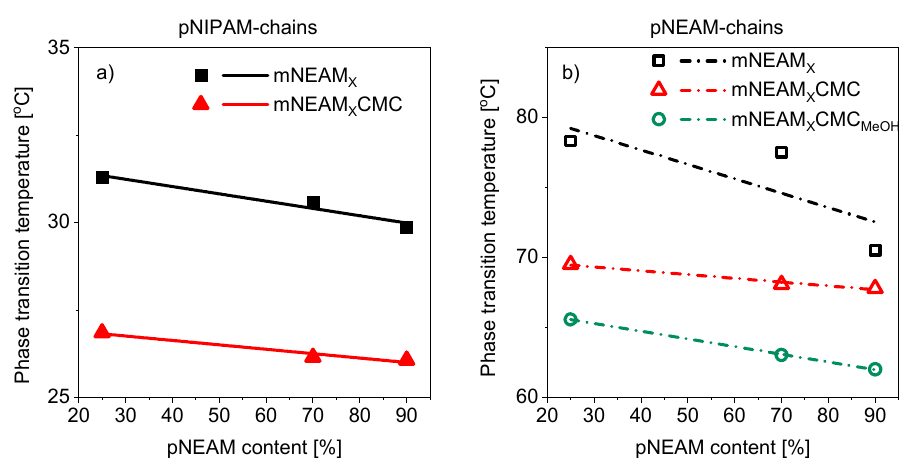
Figure 4. Phase transitions temperatures of polymers and blends associated with pNIPAM-chains ( a ) pNEAM-chains ( b ).